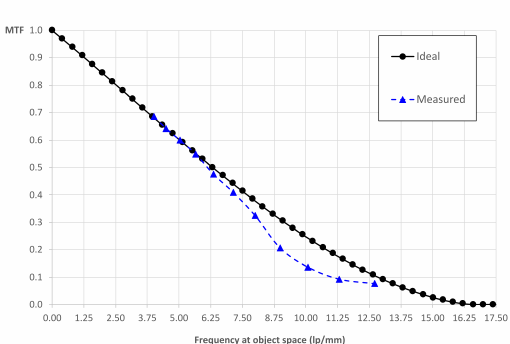
Figure 4. Intrinsic MTF: the ideal and experimental MTF of the lightfield eyepiece when it is not inserted in the microscope.